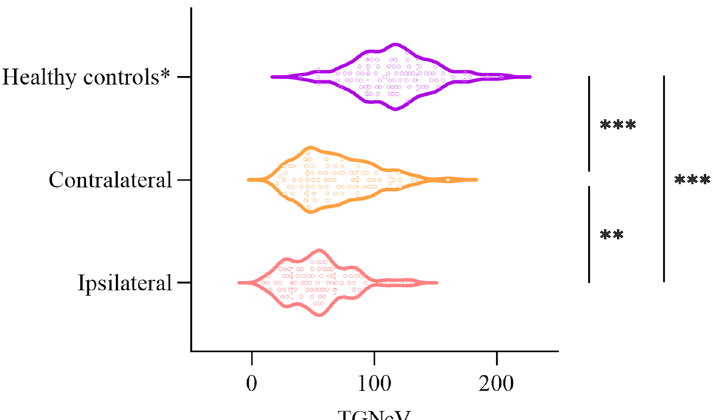
Fig. 2 The TGNcV (mm 3 ) between patients with CTN (ipsilateral and contralateral) and healthy controls. The ipsilateral TGNcV was significantly smaller compared with the contralateral TGNcV,and the bilateral TGNcVs were both significantly smaller compared with the average TGNcV of healthy controls. * Average volume of the healthy controls ((right left)/2); CTN, classical trigeminal neuralgia; TGNcV, volume of trigeminal nerve + cisternal